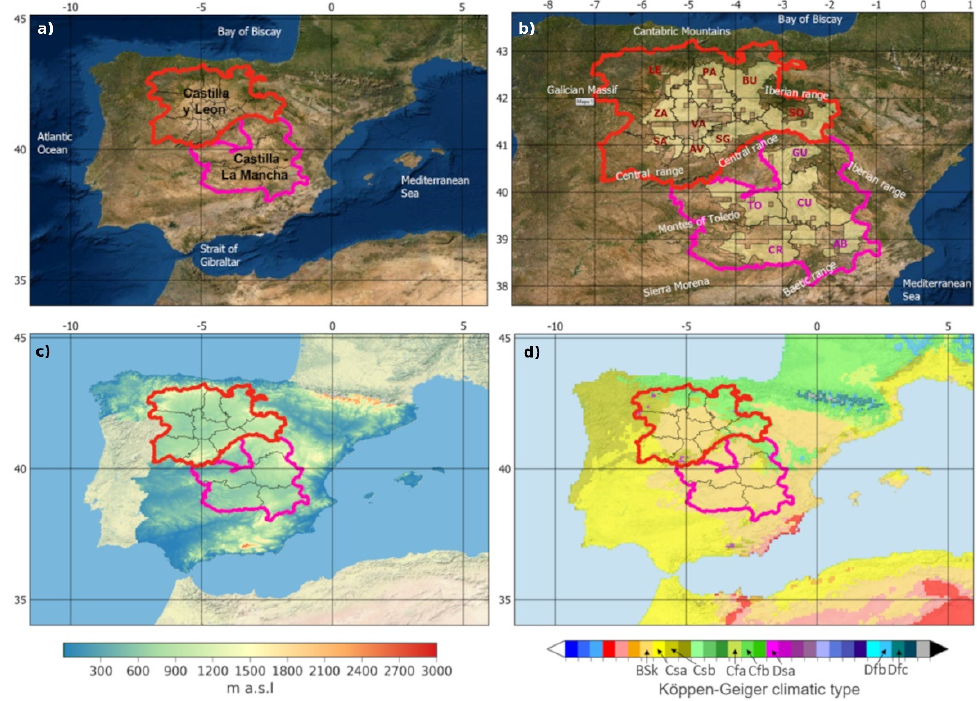
Figure 1. ( a ) Location of the study areas in the Castilla y León (CYL) and Castilla-La Mancha (CLM) regions (© ESRI satellite online maps, World Imagery, 2022). ( b ) Mask of rainfed agriculture (highlighted yellow areas) in CYL (red) and CLM (pink) based on reports of the Spanish Ministry of Agriculture and the Digital Global Map of Irrigation Areas from FAO (© ESRI satellite online maps, World Imagery, 2022). Initials indicate the province of the areas selected by the mask of rainfed agricultural districts. ( c ) Altitudinal map of the National Geographical Institute of Spain (IGN-CNIG over © ESRI physical online maps, World Imagery, 2022). ( d ) Köppen–Geiger climatic classification Ref. [43] over the study areas. Latitude and longitude in the WGS84 coordinate reference system (from data of Beck et al. (2018)).